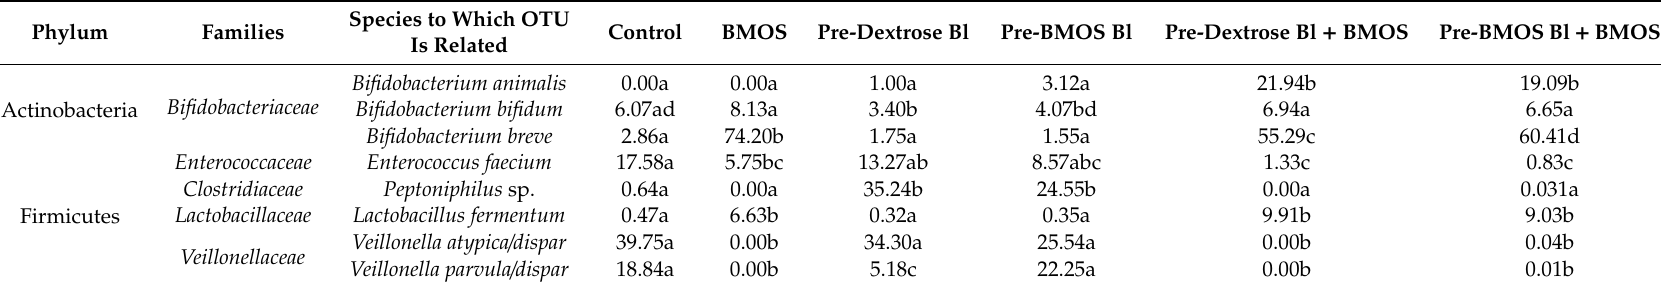
Table 1. Relative average abundance (%) of di ff erent microbial Operational Taxonomic Units (OTU) upon a 48 h fermentation of 5 g / L BMOS containing 1.5 × 10 7 CFU / mL of B. lactis previously grown on either Dextrose (Pre-Dextrose Bl + BMOS, n = 3) or BMOS (Pre-BMOS Bl + BMOS, n = 3), by an infant fecal microbiota of Donor 1, versus their respective controls (Control, Pre-Dextrose Bl and Pre-BMOS Bl, n = 3).